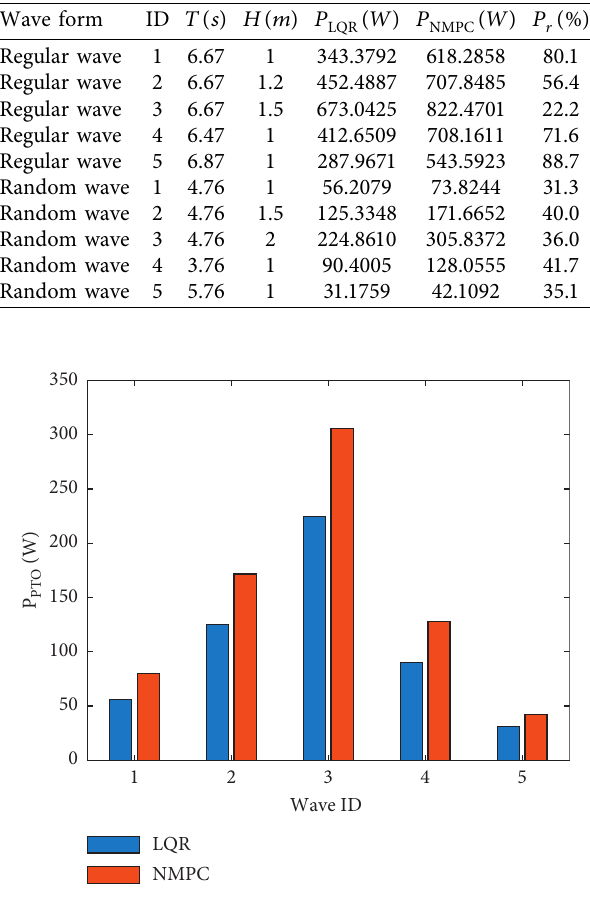
Figure 7: The power comparison of LQR and NMPC when ex- posed to the random wave